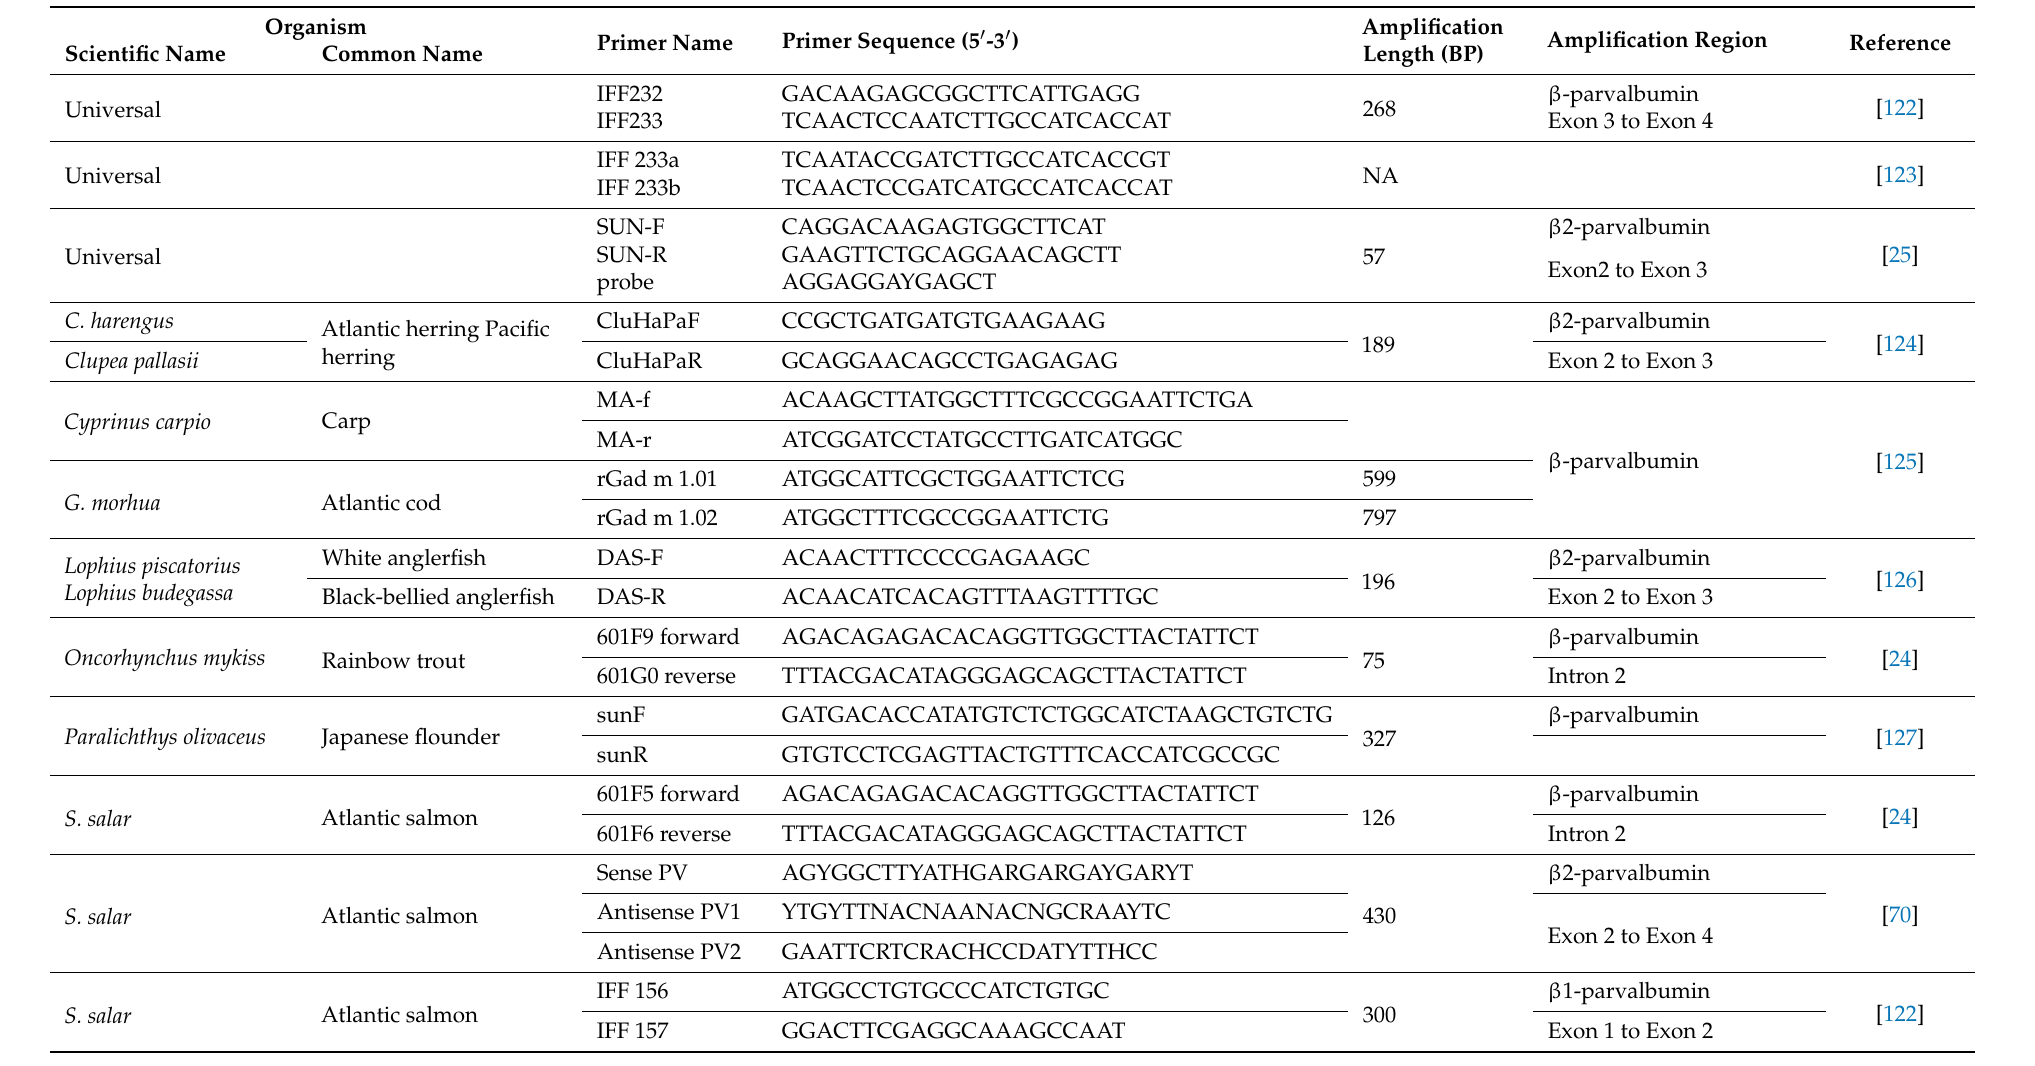
Table 2. Universal and species-specific primers that have been used for detection of PVALB